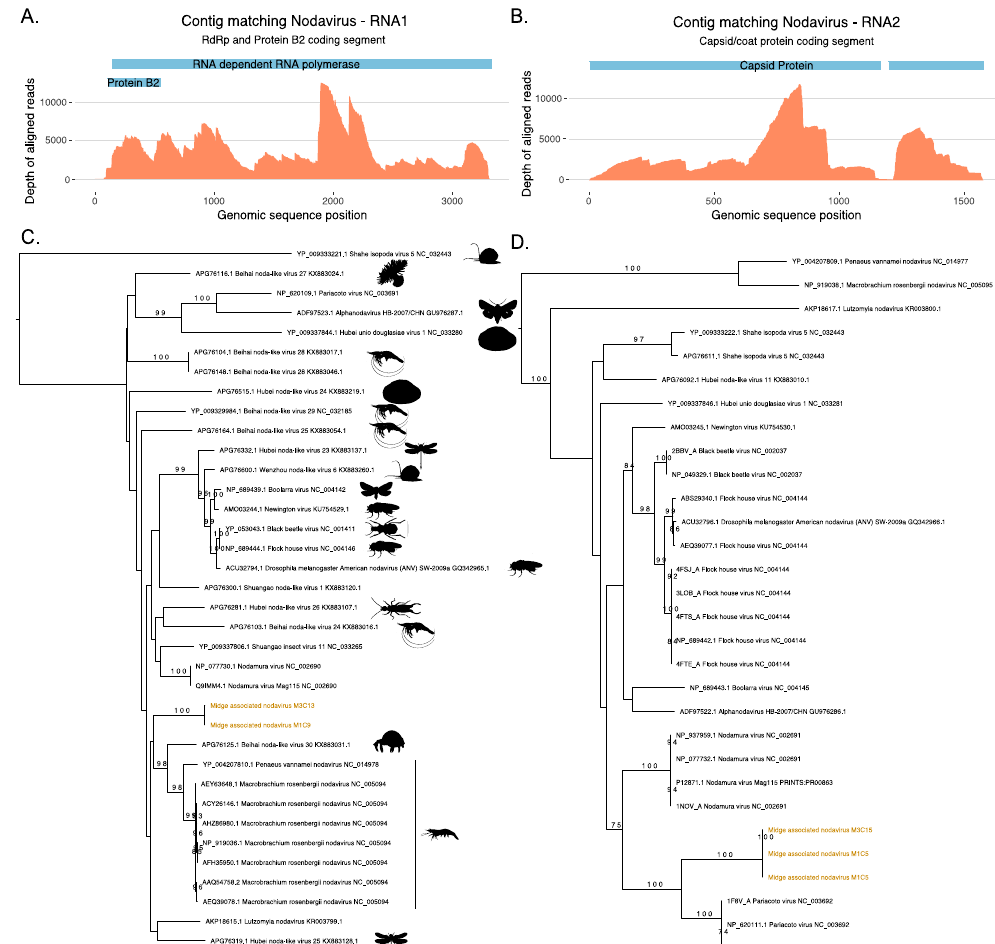
Figure 3. Novel nodavirus segments identified in the sample. Depth of coverage (orange) across the RNA1 ( A ) and RNA2 ( B ) segments with the coding regions for RNA dependent RNA polymerase (RdRp), Protein B2 and Capsid proteins shown in blue. ( C ) Phylogeny of the RdRp protein from the RNA1 segment and ( D ) phylogeny of the coat protein from the RNA2 generated using RAxML and showing the classification of the novel midge nodavirus RdRp and coat proteins with respect to existing protein sequences available in Genbank.